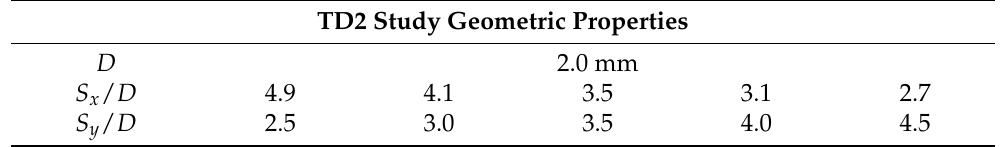
Table 1. Properties for the TD2 film spacing variation